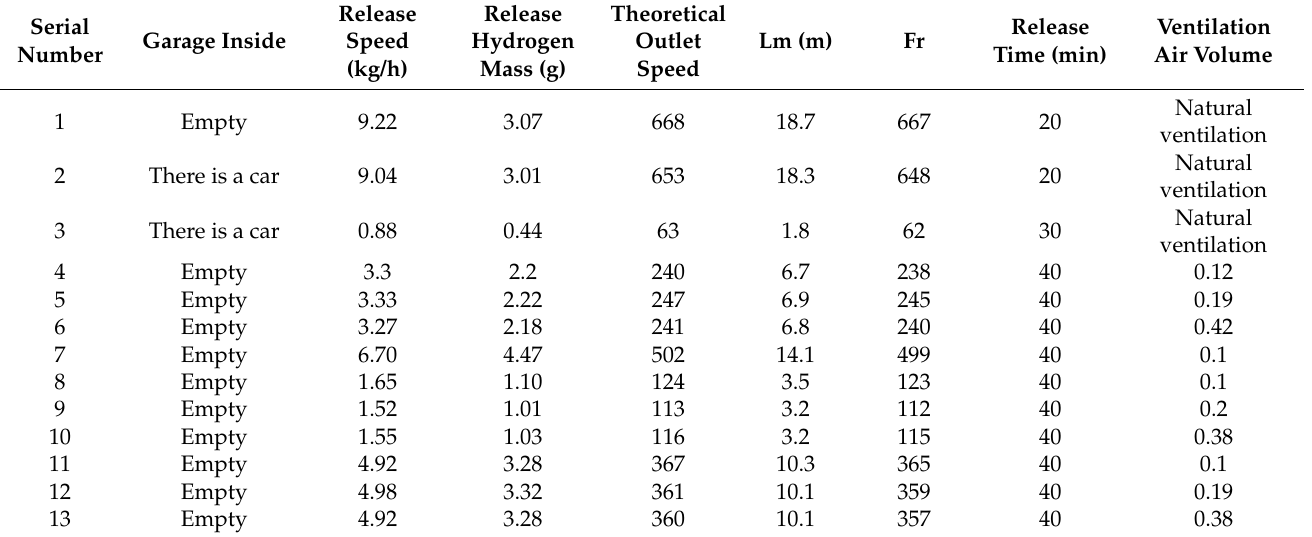
Table 4. Hydrogen release test in a parking